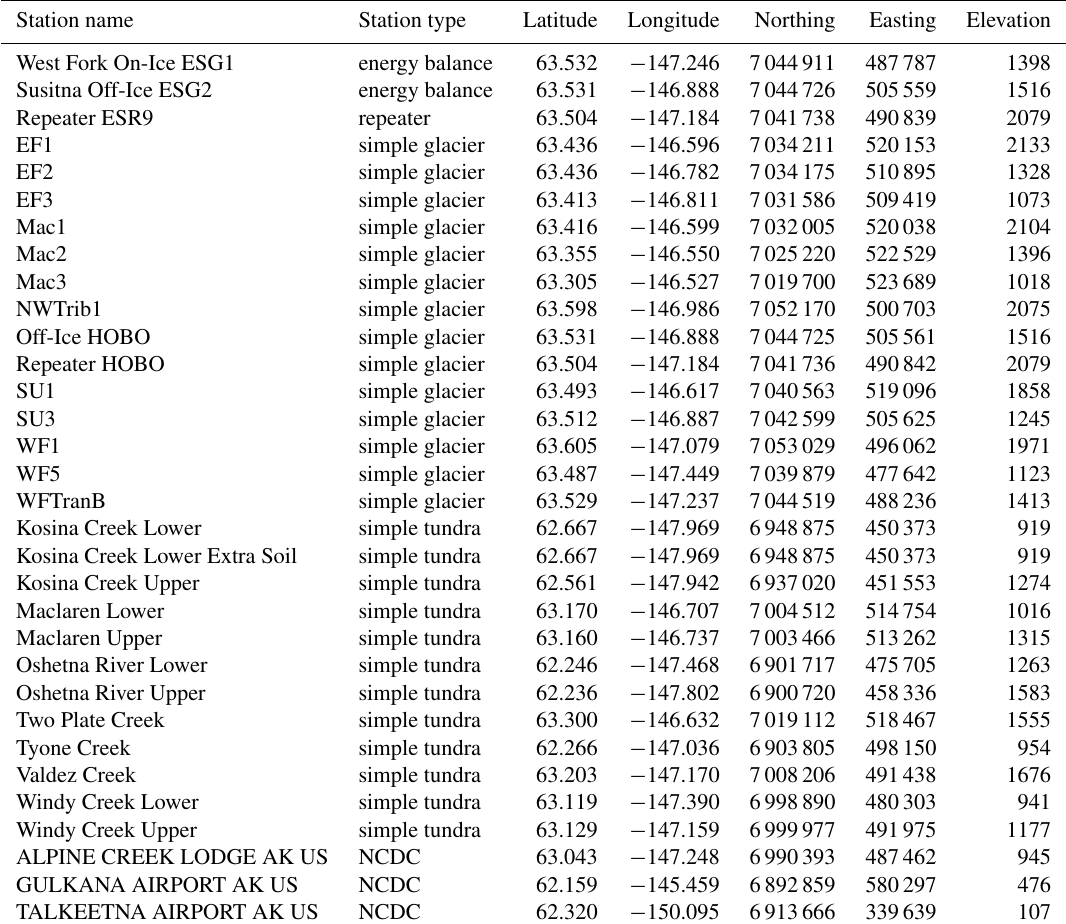
Table A1. Properties of meteorological stations referenced in this study. See Fig. 3 for example photos of our station types. The northing and easting are in UTM Zone